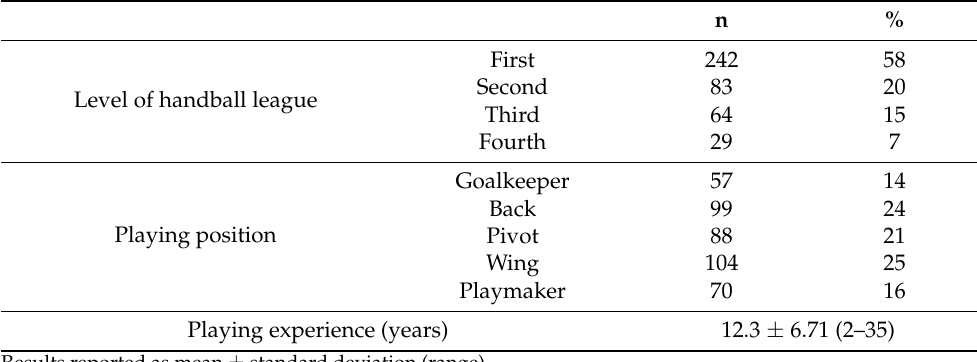
Table 1. Description of the sample (n = 418) regarding origin and handball activity.